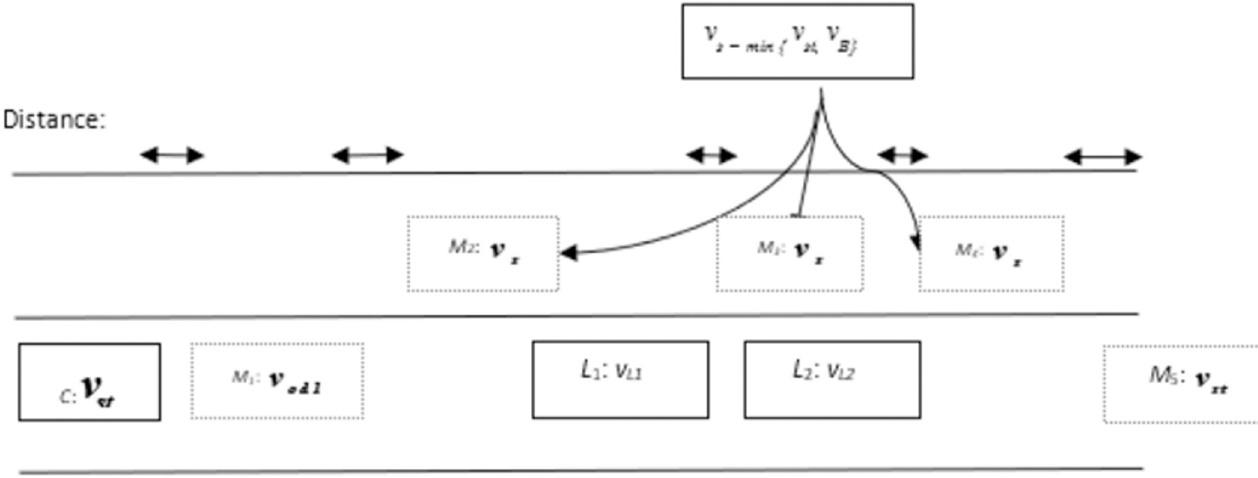
Fig 7. Position of marker targets for scenario